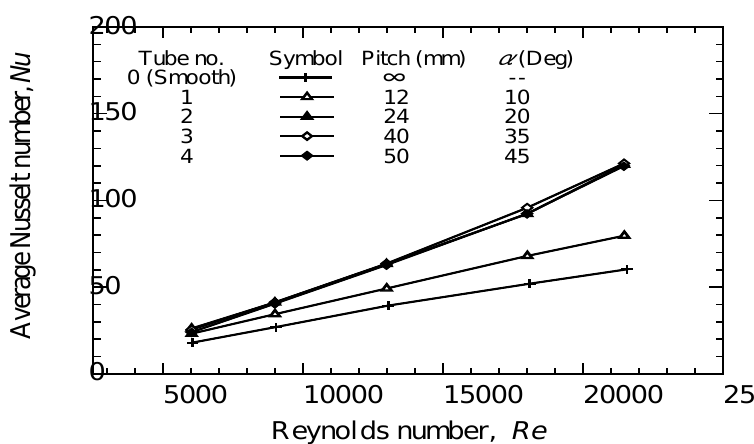
Figure 7: Variation of average Nusselt number against Reynolds number for smooth tube and wire-coil inserted tubes.